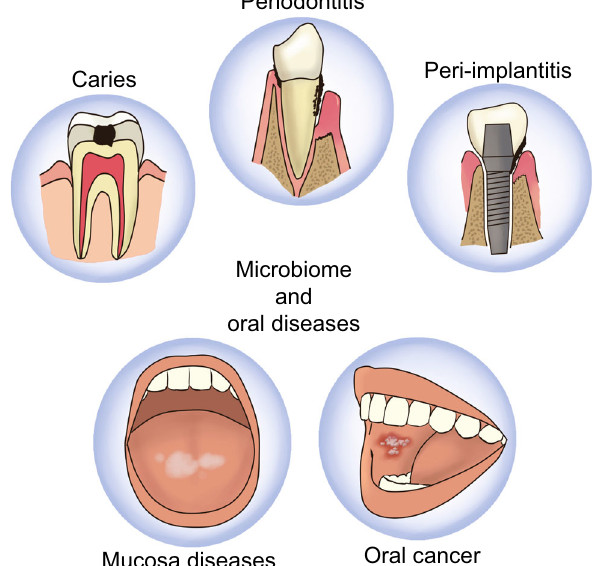
Figure 2. Oral microbiome and oral diseases. Various kinds and various numbers of bacteria have been found in people with different oral diseases such as dental caries, peridontal diseases, mucosal diseases (e.g., lichen planus, leukoplakia), oral cancer and